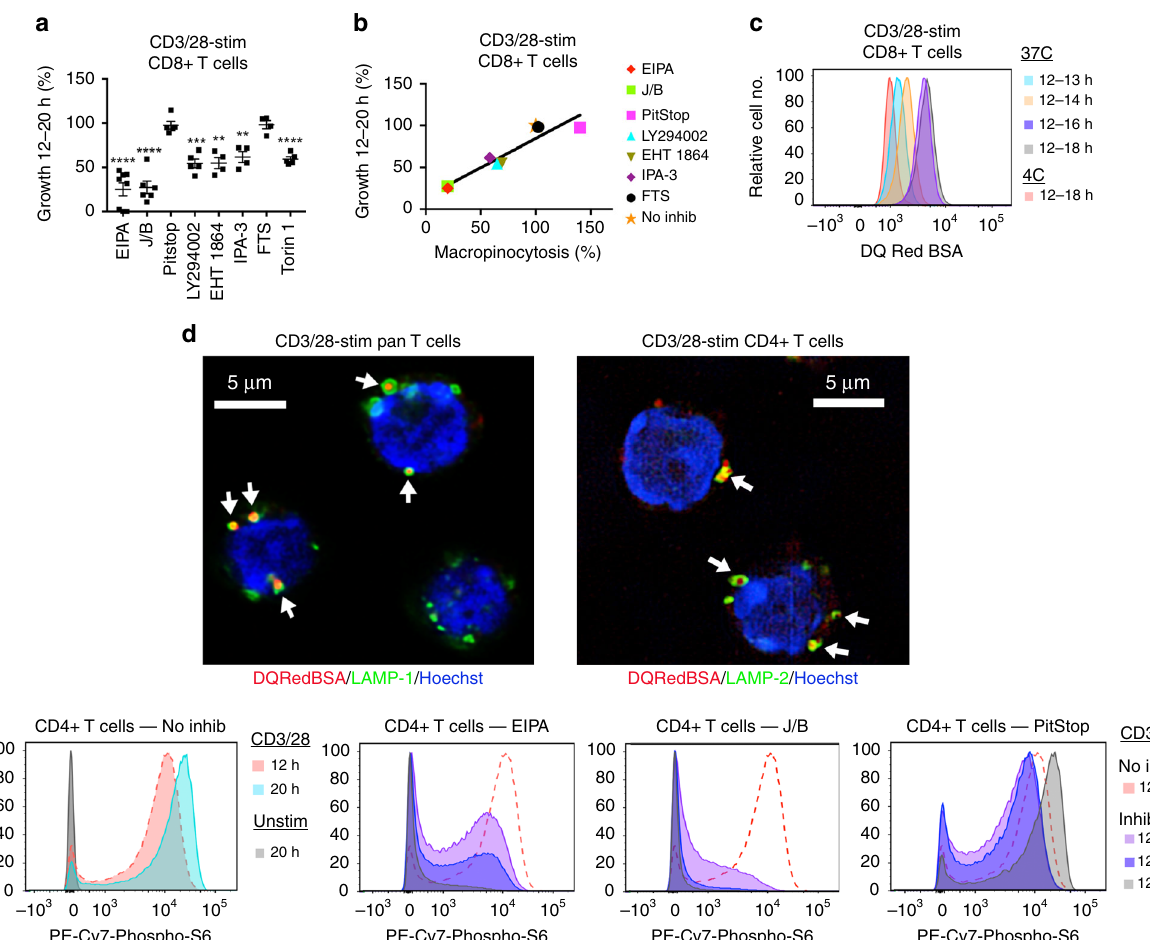
Fig. 4 Macropinocytosis promotes T cell growth by sustaining the activation of mTORC1. a Murine splenocytes were stimulated with CD3/28 mAb for 20 h in the absence or presence of the indicated inhibitors that were added to cultures at 12 h. For each inhibitor, the mean percentage±1 SEM of CD8 + T cell growth between 12 and 20 h relative to growth in the absence of inhibitor in the same experiment is shown (see Methods) (EIPA, n = 8; J/B, n = 6; PitStop, n = 5; LY294002, n = 5; EHT 1864, n = 4; IPA-3, n = 4; FTS, n = 4; Torin 1, n = 5 independent experiments). ** P < 0.01, *** P < 0.001, **** P < 0.0001 by Student ’ s 1-sample 2-sided t -test. b Graph shows mean percentage macropinocytosis (Fig. 3b and Supplementary Fig. 2c) vs. mean percentage growth ( a ) for CD8 + T cells for each inhibitor. c , d Splenocytes ( c ) or puri fi ed pan T cells or CD4 + T cells ( d ) were stimulated with CD3/28 mAb for 12 h before incubation with DQ Red BSA for the indicated times at the indicated temperatures ( c ) or 4 h at 37 °C ( d ). Traf fi c of DQ Red BSA to lysosomes was assessed by fl ow cytometry ( c ) and confocal microscopy ( d ). Flow cytometry data are representative of four independent experiments (See Supplementary Fig. 3e). Arrows in ( d ) show accumulation of DQ Red BSA in LAMP-1-positive or LAMP-2-positive lysosomes as determined by staining with respective antibodies. The mean percentage± 1 SEM of LAMP-1-positive or LAMP-2-positive lysosomes that contained DQ Red BSA per cell was calculated at 77.3 + 3.9 ( n = 35 cells) and 84.9 + 3.8 ( n = 23 cells), respectively. e Splenocytes were unstimulated or stimulated with CD3/28 mAb for different times in the absence or presence of inhibitors added at 12 h. Relative amounts of phospho-S6 in CD4 + T cells were determined by fl ow cytometry. All panels are from the same experiment. The red dashed line in each panel indicates the 12 h positive control. Data are representative of 6 independent experiments performed with EIPA and three independent experiments performed with J/B and PitStop (see Supplementary Fig. 3h). Source data are provided as Source Data fi